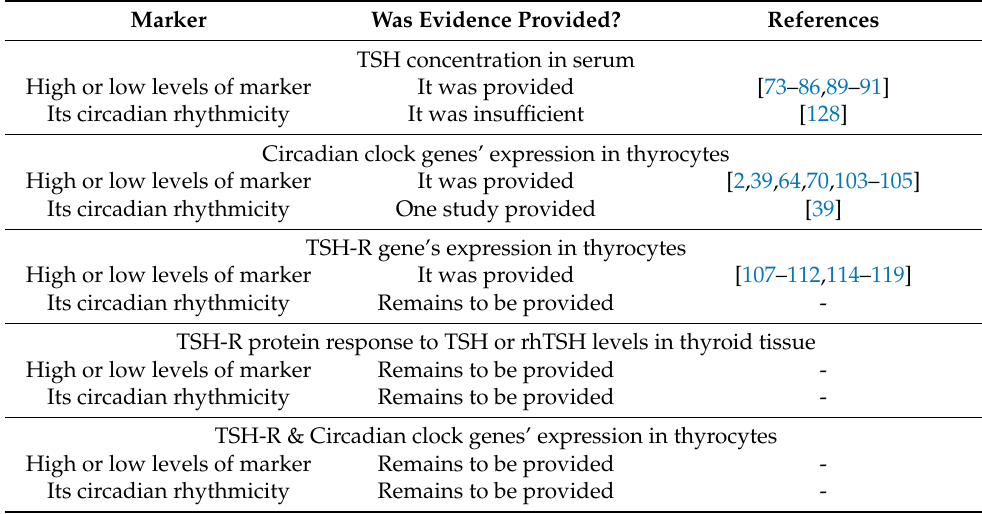
Table 1. Evidence for potential clock-associated preoperative biomarkers for thyroid carcinoma. Marker Was Evidence